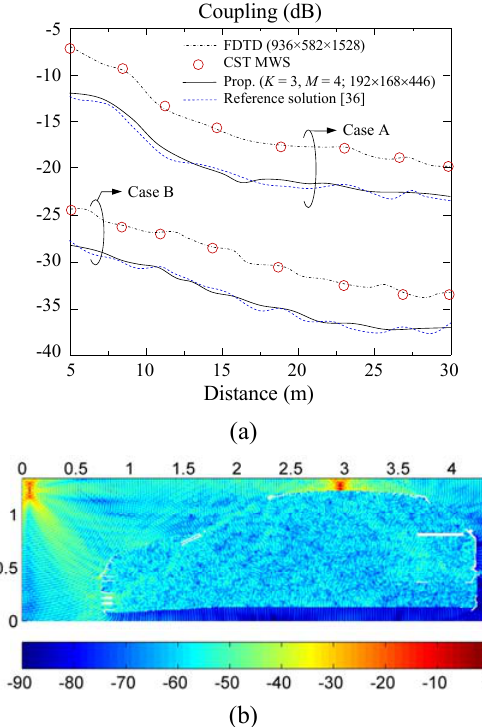
Figure 27: (a) Coupling between two vehicles versus their distance for two communication link cases (A: antennas mounted on the roofs and B: antennas mounted at the back of the vehicles). (b) Electric field distribution (in dB) at the outer surface of the vehicle for a roof-mounted antenna. lays in the exchange of information between moving vehicles or between vehicles and infrastructure in order to achieve high levels of efficiency and electromagnetic coupling (Fig. 26b).